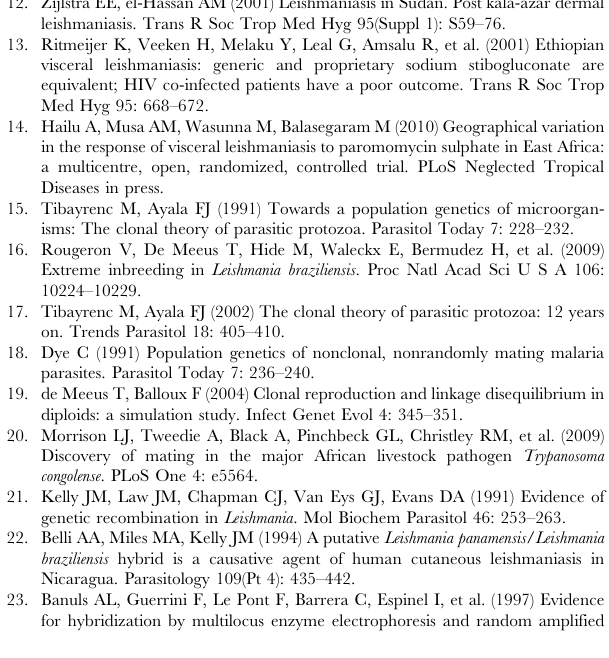
Table S5 Descriptive statistics: polymorphism, heterozygosity and inbreeding for the BAPS